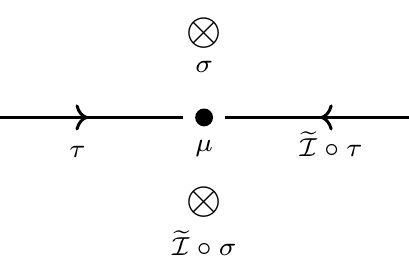
Figure 4: Cell decomposition of Y = (cid:82) 2 respecting inversion symmetry around µ